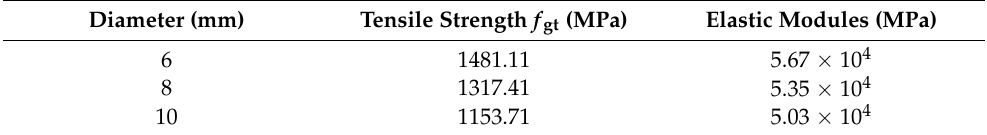
Table 4. Material properties of GFRP bars.